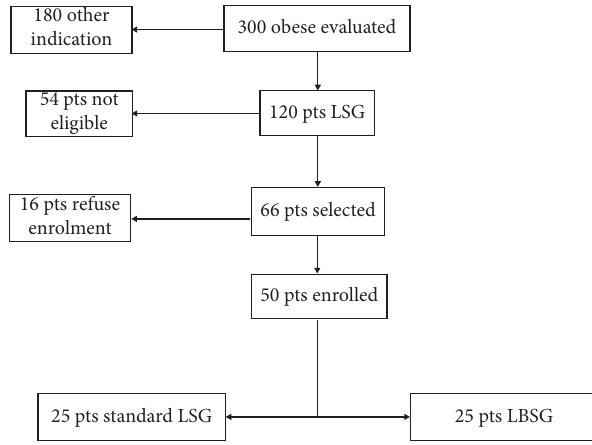
Figure 1: Flow diagram of patients’